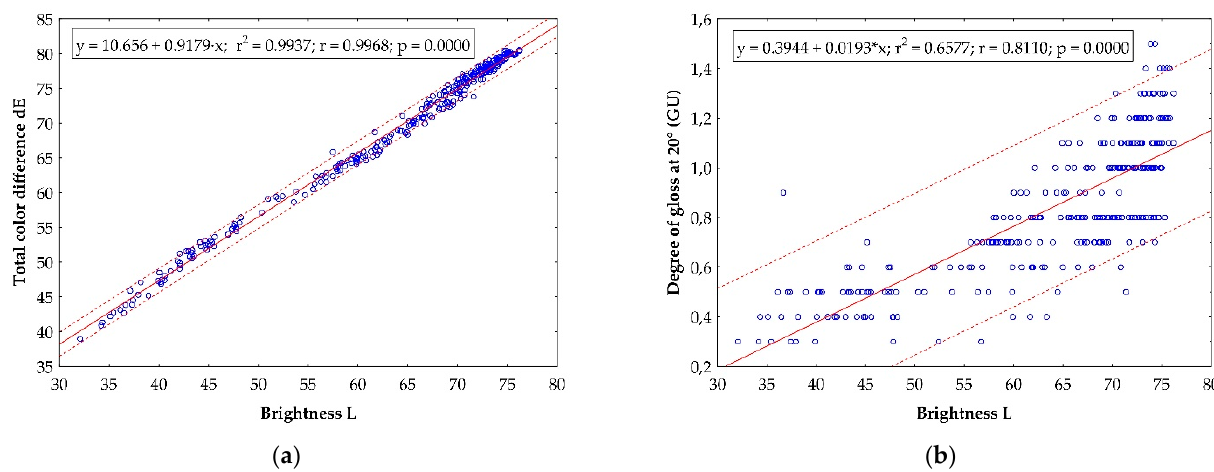
Figure 15. The relationship between ( a ) brightness and total colour difference, and ( b ) brightness and degree of gloss at 20°, are shown regardless of heat-treatment degree. Significance level is at a 95%.